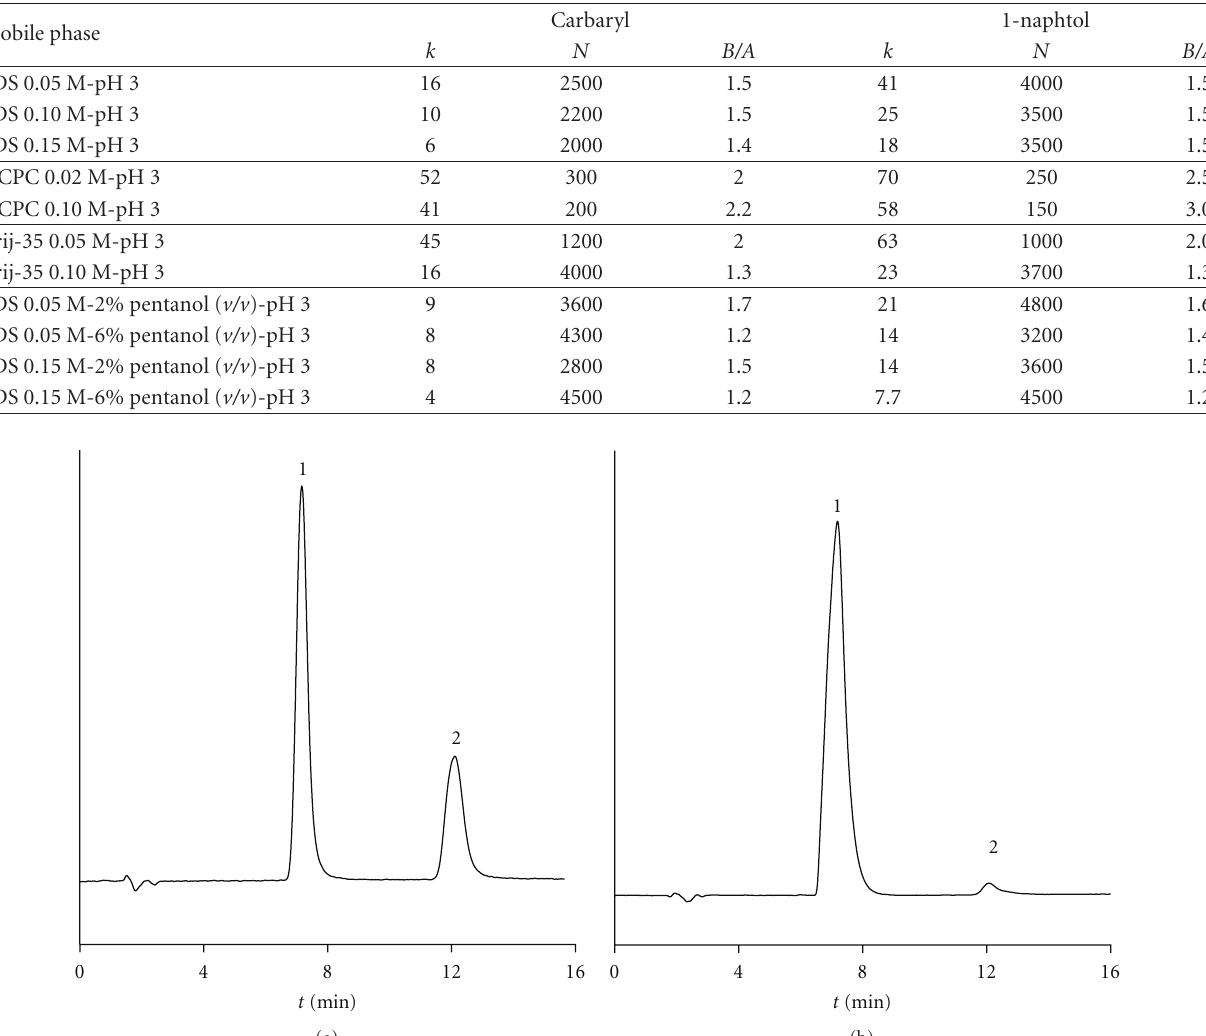
Figure 1: Chromatograms showing the separation of carbaryl (1) and 1-naphthol (2) using the mobile phase 0.15 M SDS-6% ( v/v ) pentanol- 0.01 M NaH 2 PO 4 (pH 3). The injected samples were (a) water (after 10 days being spiked with 500 ng mL − 1 ) and (b) soil (2 days after being spiked with 500 ng mL − 1